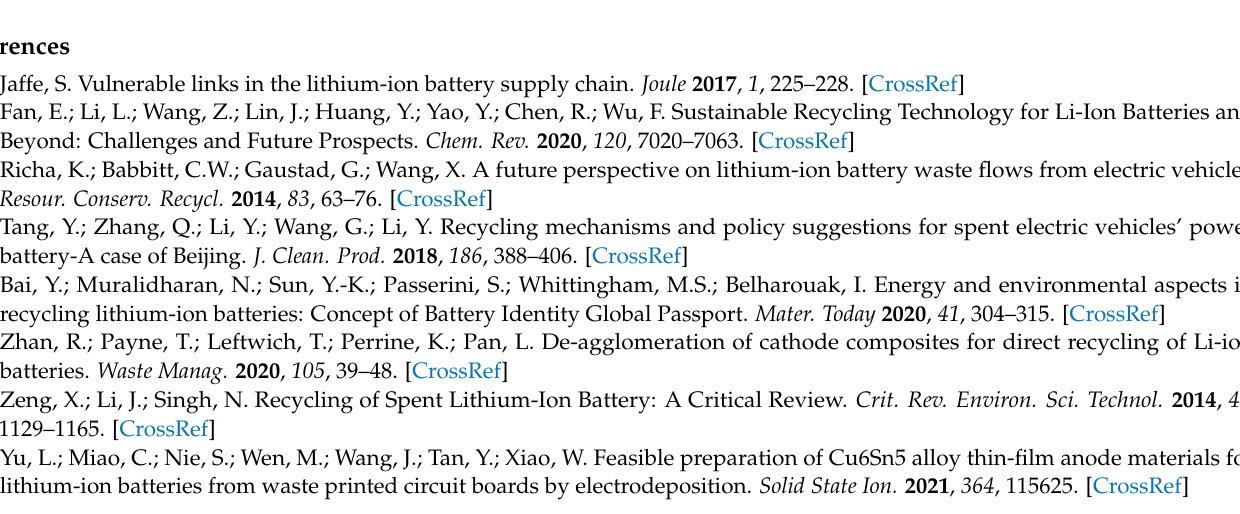
Figure 9. Three aspects of the sustainable and intelligent eco-system of LIBs [110].